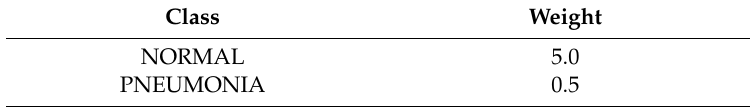
Table 1. Matrix of penalties applied to the cost function in order to avoid biased results from the CNN.